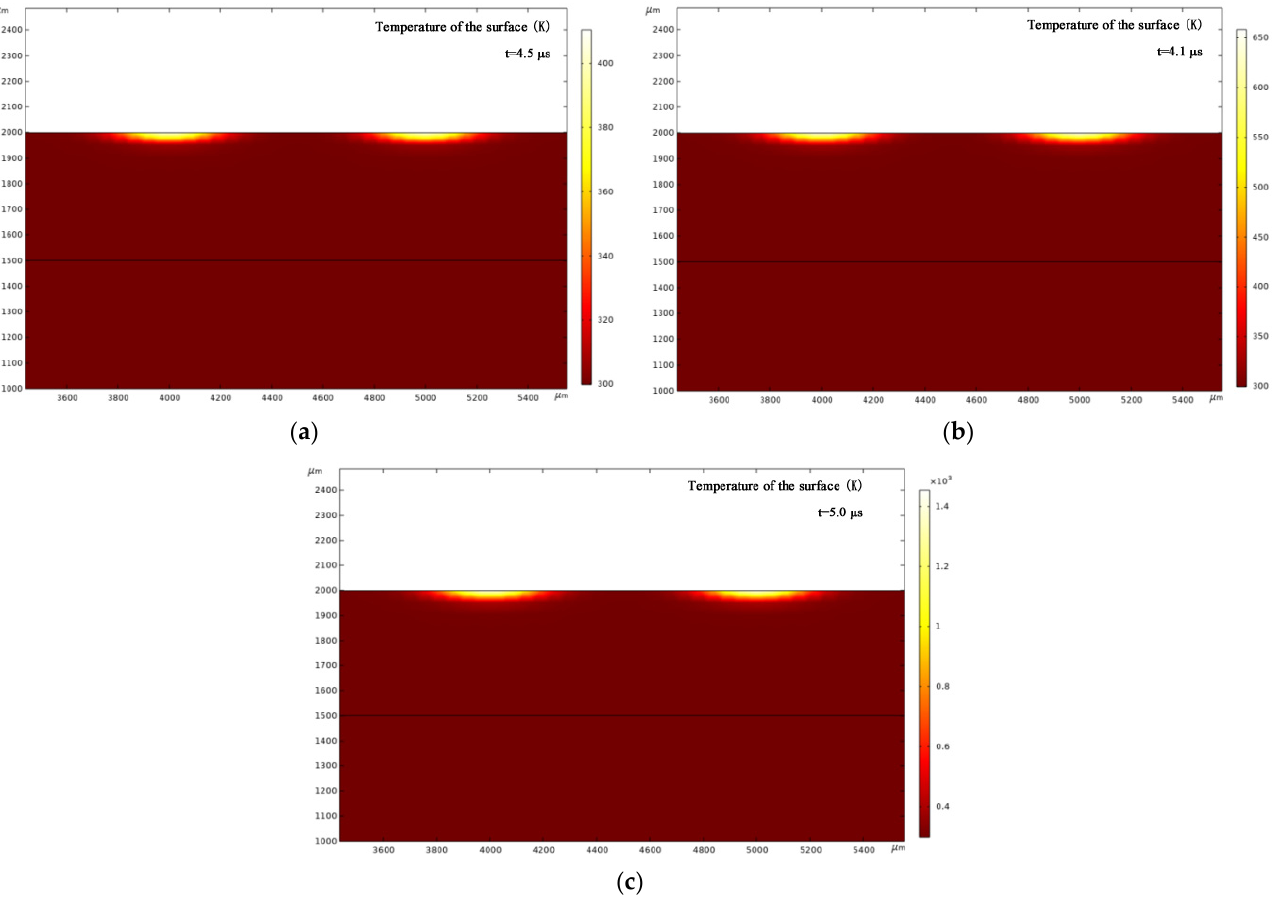
Figure 9. Temperature field distribution under different energies of the shaping laser. ( a ) 6 W; ( b ) 20 W; and ( c ) 60 W.